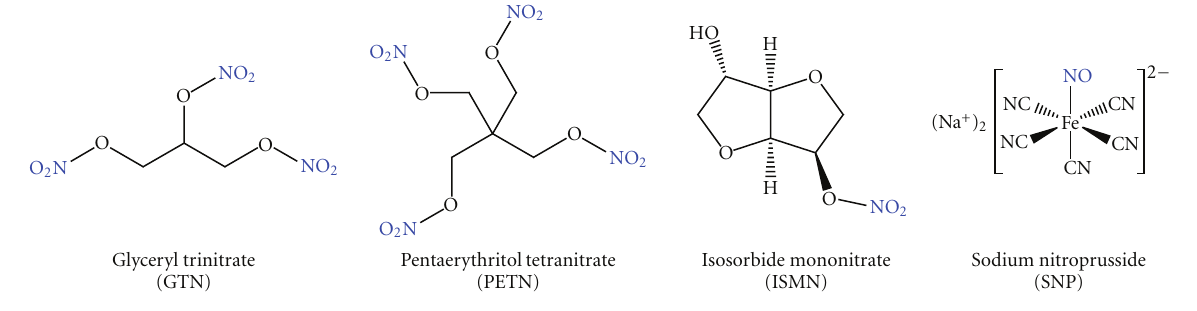
Figure 4: Clinically used NO donor drugs